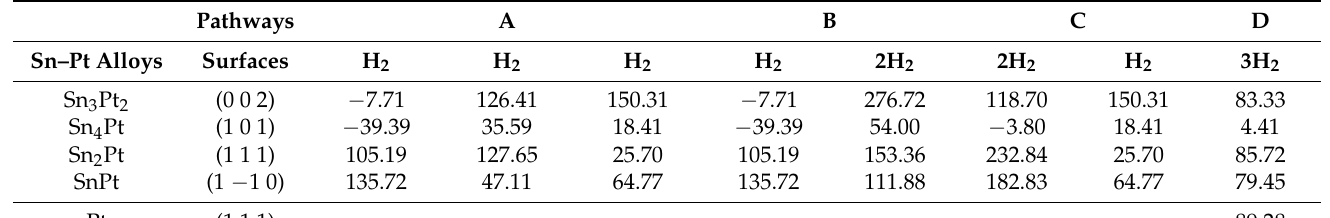
Table 3. Calculated reaction energies on the Sn–Pt-based alloy surfaces (in eV) for the pathways